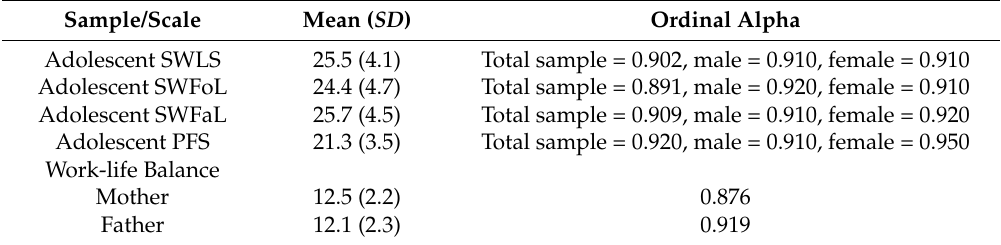
Table 2. Mean, standard deviation ( SD ) and internal reliability (Ordinal Alpha) of the Satisfaction with Life Scale (SWLS), Satisfaction with Food-related Life (SWFoL), Satisfaction with Family Life (SWFaL) Perceived Family Support (PFS) and Work-life Balance (WLB)